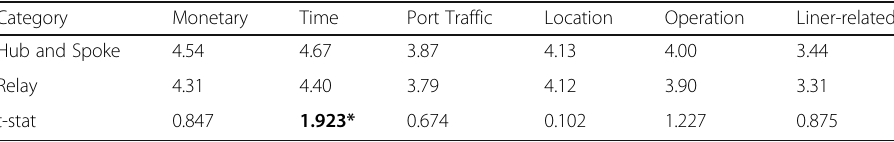
Table 8 Comparisons of the Significance of Categories between Hub and Spoke and Relay Category Monetary Time Port Traffic Location Operation Liner-related Hub and Spoke 4.54 Relay 4.31